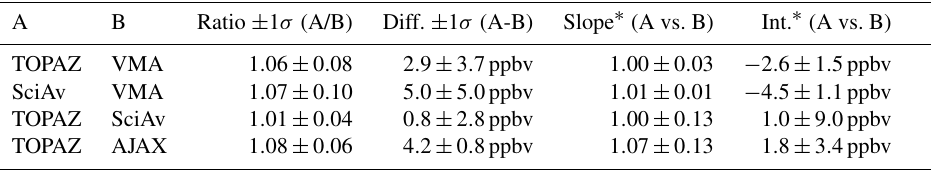
Table 1. Summary of the lidar, surface, and aircraft comparisons.